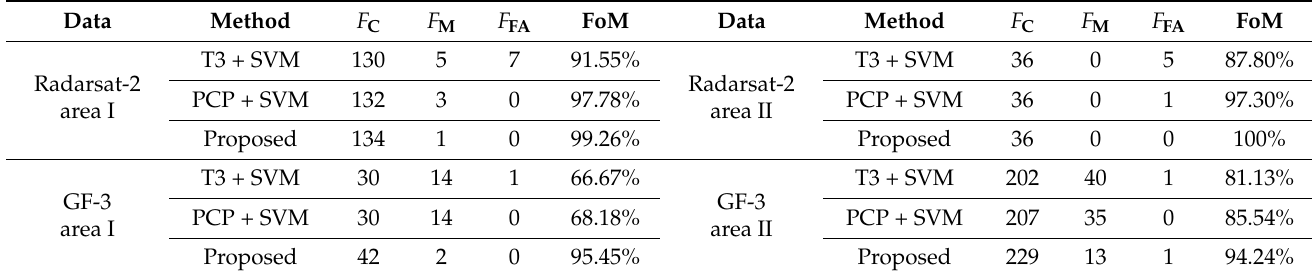
Table 4. Quantitative results’ comparison with the Radarsat-2 area II training